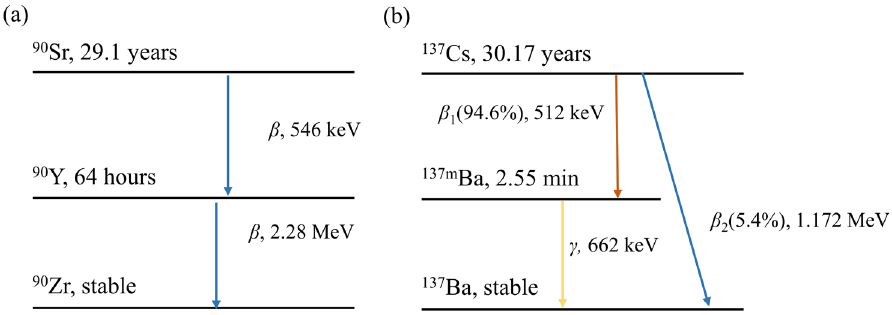
Figure 6. Schematic diagram of decay series for ( a ) 90 Sr, ( b ) 137